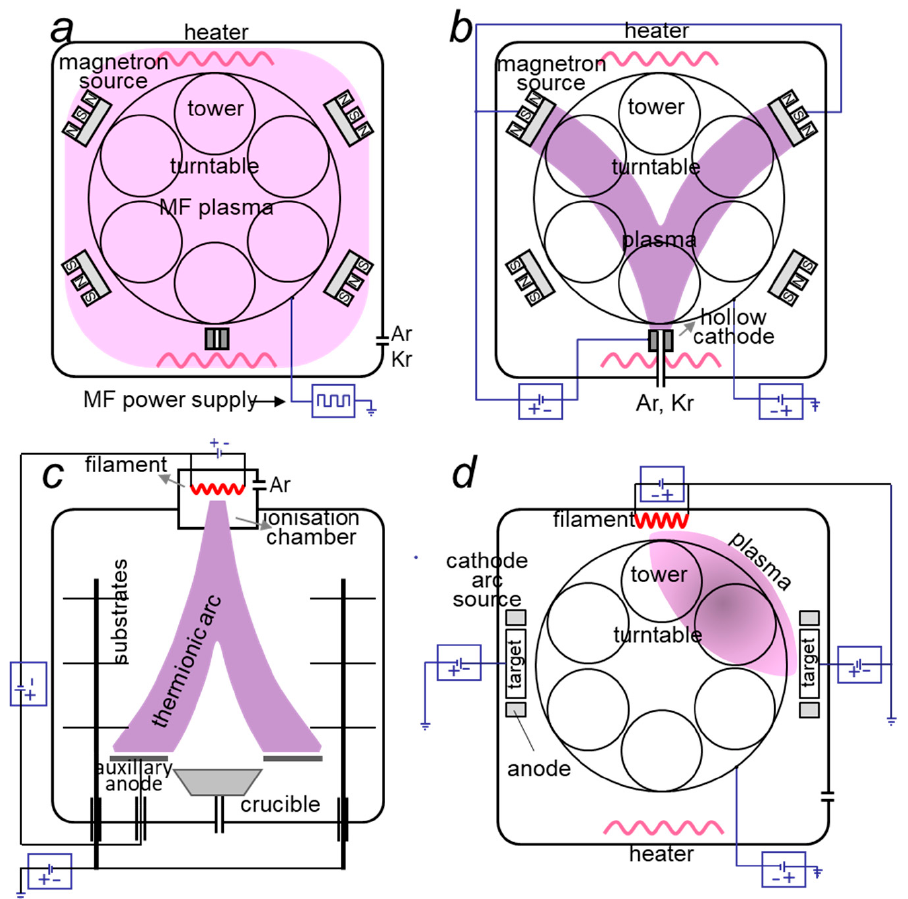
Figure 6. Examples of ion etching modes in the three di ff erent physical vapor deposition (PVD) systems we used for deposition of PVD hard coatings: ( a ) MF etching and ( b ) etching with hollow cathode plasma source (DC bias) in magnetron sputtering system CC800 / 9 ML; ( c ) ion etching (DC bias) in thermionic arc evaporation system BAI 730; ( d ) ion etching (DC bias) cathodic arc deposition AIPocket.